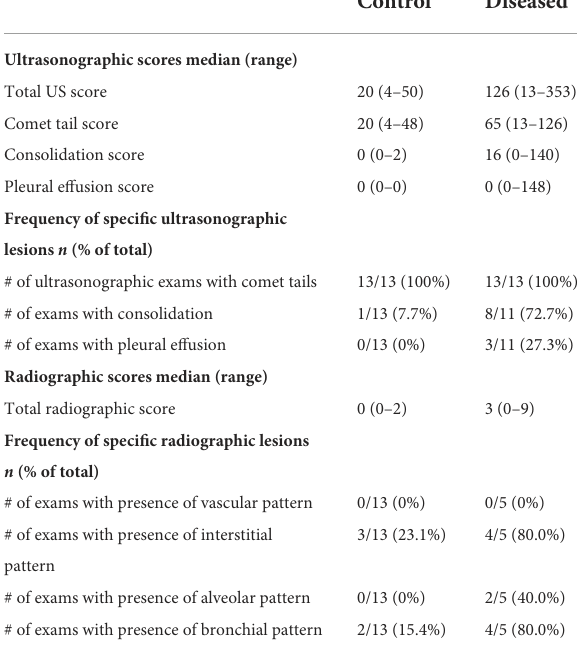
TABLE 1 Ultrasonographic and radiographic findings for controls (healthy horses) and diseased horses (horses with bacterial